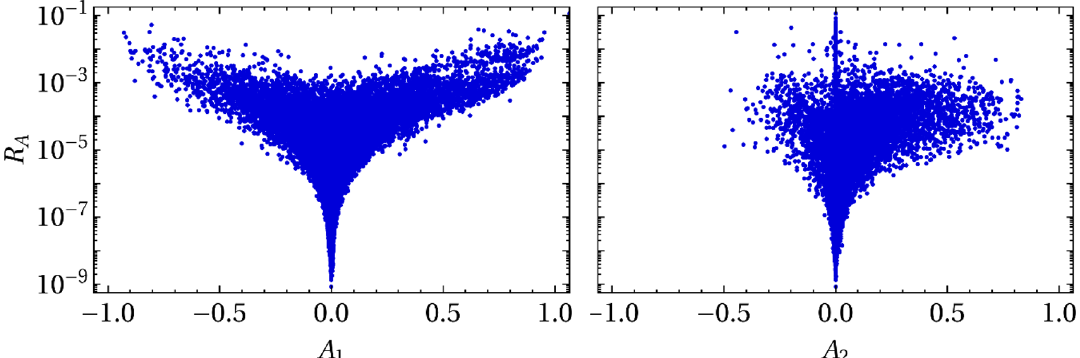
Figure 7 . Scatter plots of A 1 (left panel) and A 2 (right panel) against R A for the blue points of figure 4. The definitions of A 1 and A 2 are given in